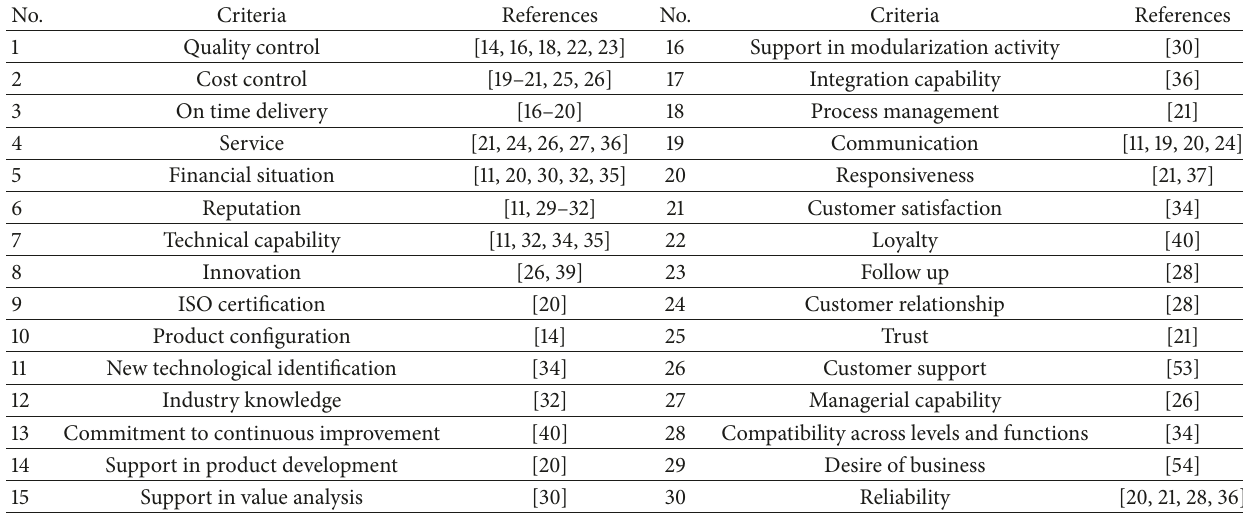
Table 4: Primary indexes of modular supplier selection.